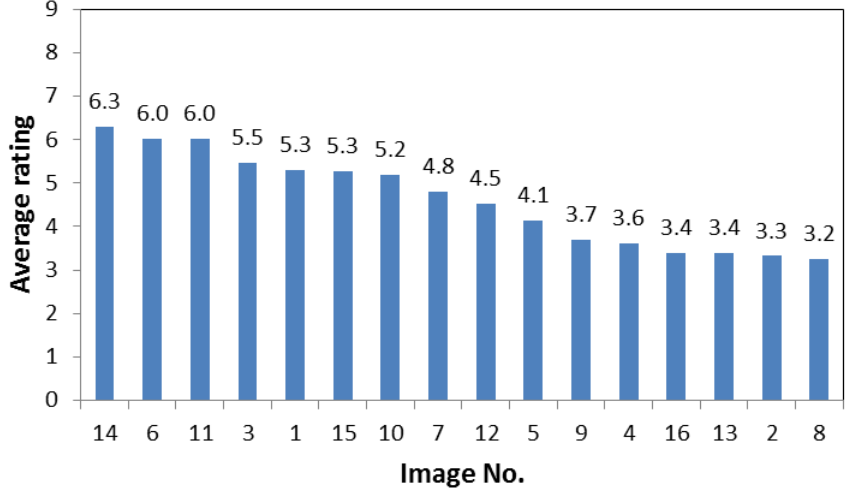
Figure 1. Average rating for question 2: integration of the structure in the picture with the natural environment.